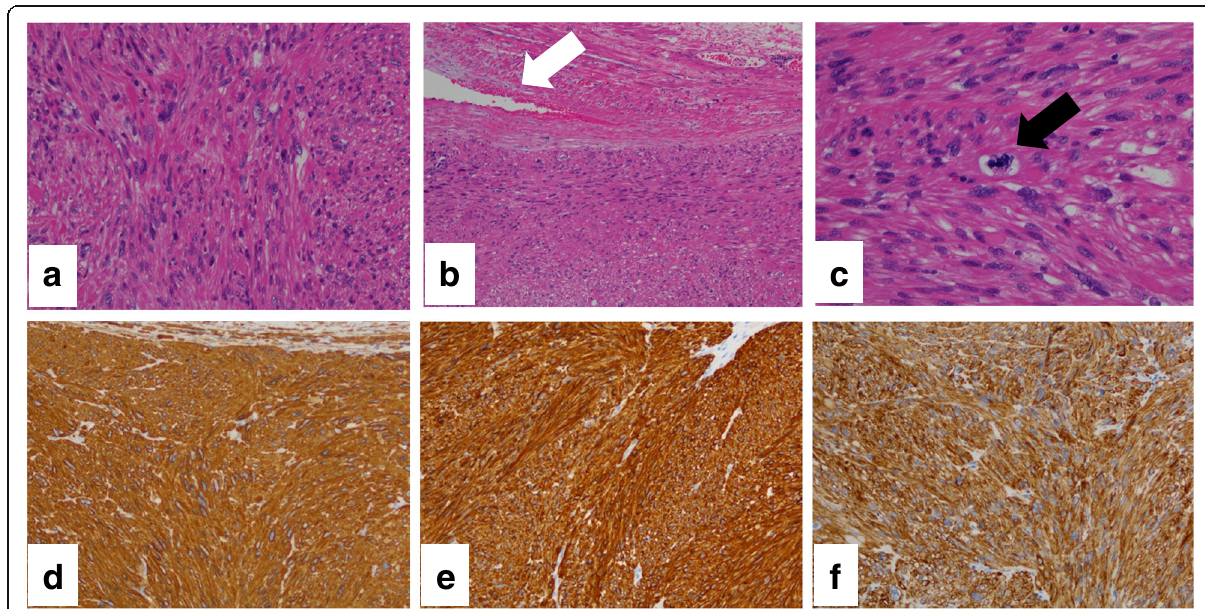
Fig. 5 Histological findings of the leiomyosarcoma. a Hematoxylin and eosin staining (HE, × 200) showing atypical spindle cells with interlacing fascicles and b tumor cells connected to the right ovarian vein (white arrow; HE, × 100). c Mitosis in the tumor cell (black arrow; HE, × 400). Immunohistochemical staining (× 100) showed positive results for d α -SMA, e desmin, and f